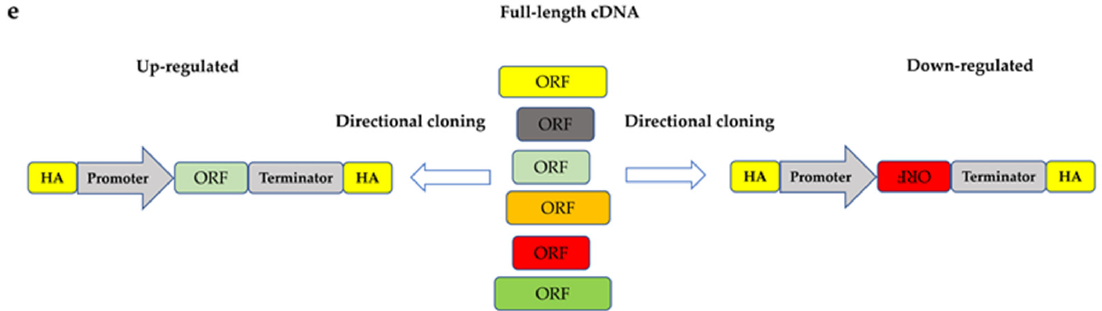
Figure 1. Summary of genome evolutionary engineering. ( a ) Fusion of ssDNA-binding protein and cytidine deaminase. ( b ) CIRSPRi/CRISPRa. ( c ) SCRaMbLE in vivo provides a versatile platform to generate diverse genetic variants. ( d ) SCRaMbLE in vitro is conducted via purified Cre in tube and the obtained library is transformed into S. cerevisiae to generate diverse phenotypes. ( e ) Directional cloning obtained from cDNA simultaneously realized up- and downregulations.